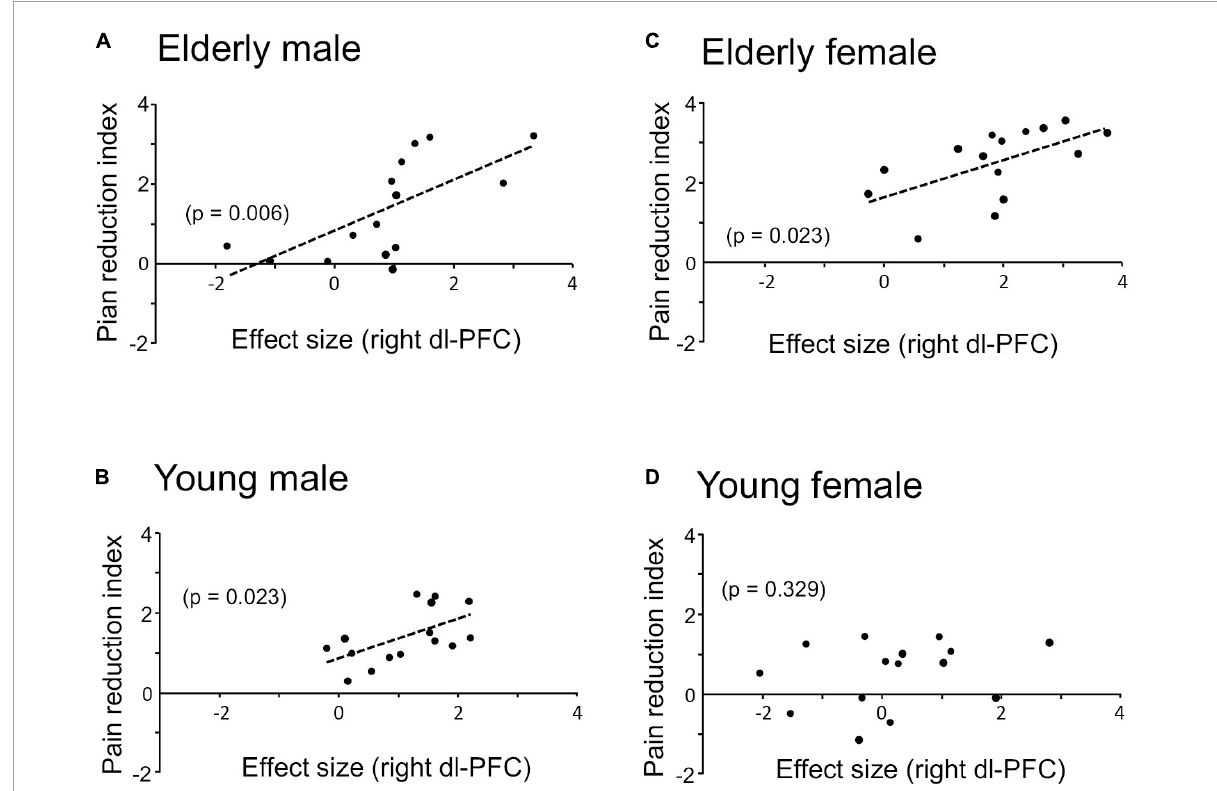
FIGURE5 Relationships between pain reduction indices and effect sizes of cerebral HbO responses to the LF sound in the right dl-PFC in elderly male (A) , elderly female (B) , young male (C) , and young female (D) groups. Significant positive correlations are observed in all groups except the young female